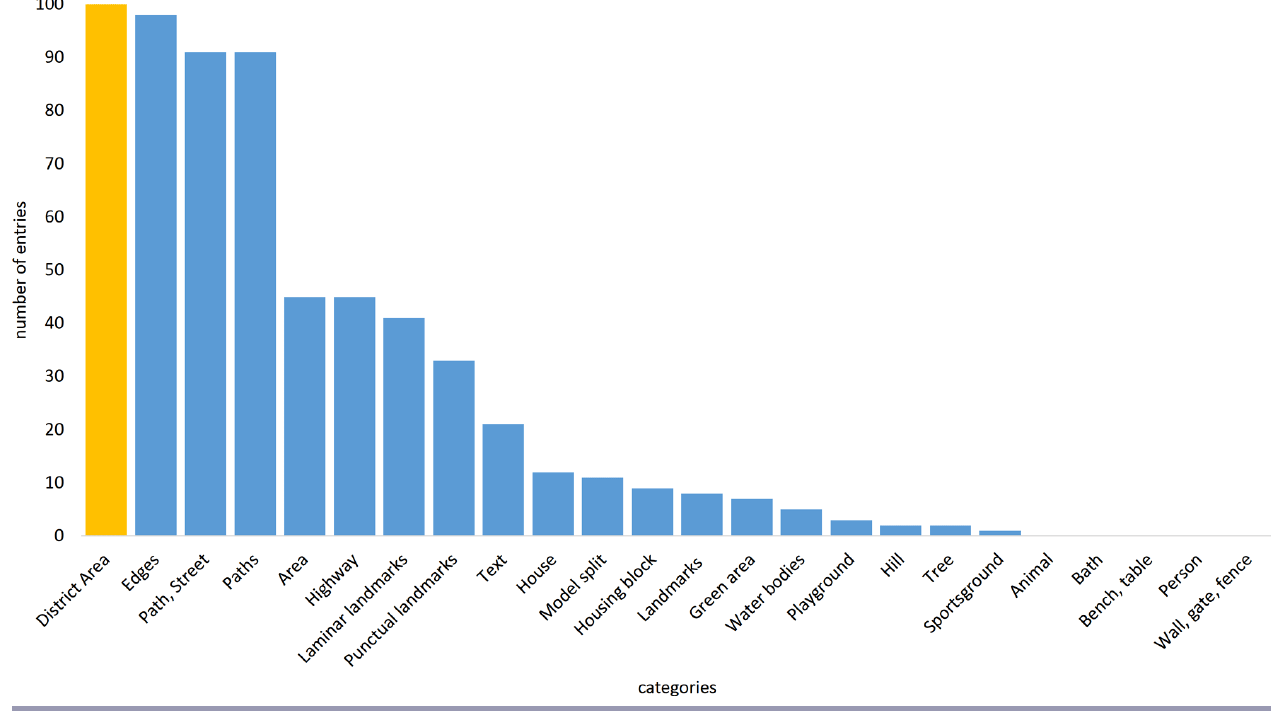
Fig. 4 . Frequency of the sketched elements in the mental maps classified in the (adapted) appraisive and designative categories according to Gillespie (2010) and Larsen and Harrington (2016), as cited in Otto (2018); differences between the first four categories and the rest are significant at p = 0.05 level. Laminar and Punctual landmarks, laminar = axis-like; punctual = point-like.